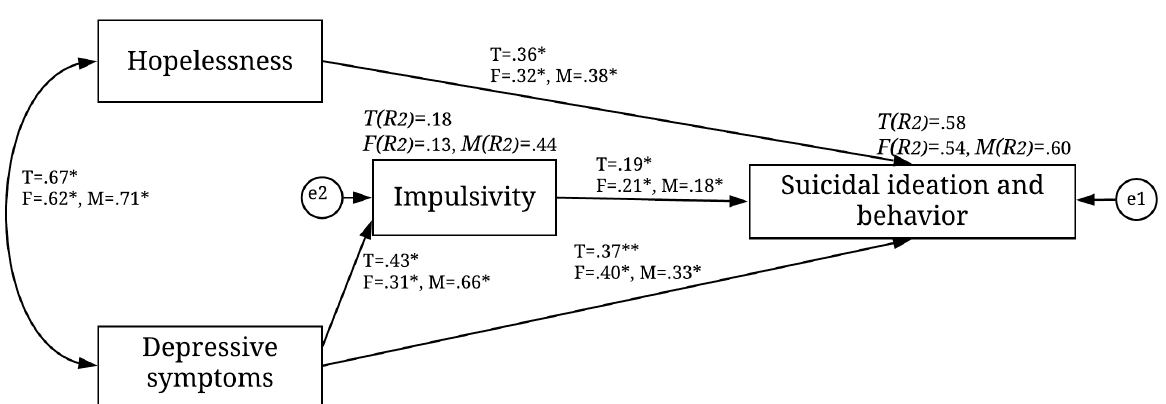
Figure 2. Mediation of impulsivity by gender on the symptoms of depression * p< .01; ** p< .001. Note: T=Total sample; F=Female;